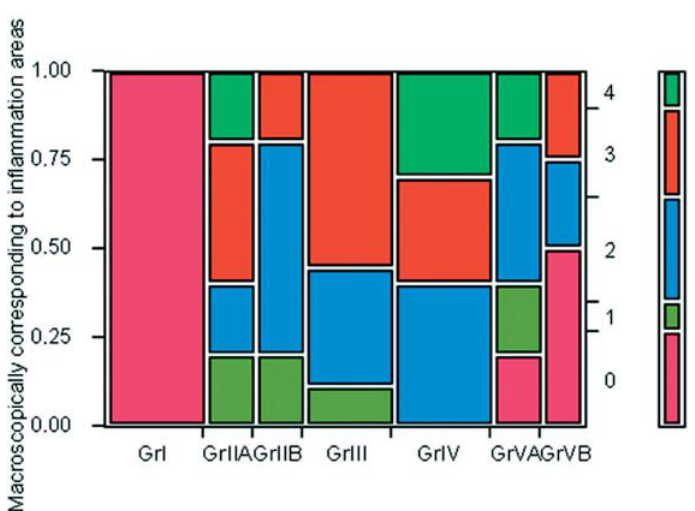
Figure 7- Macroscopic observation of the gastric mucosa in relation to parameter - Macroscopically corresponding to (cid:76)(cid:81)(cid:192)(cid:68)(cid:80)(cid:80)(cid:68)(cid:87)(cid:76)(cid:82)(cid:81)(cid:3)(cid:68)(cid:85)(cid:72)(cid:68)(cid:86)